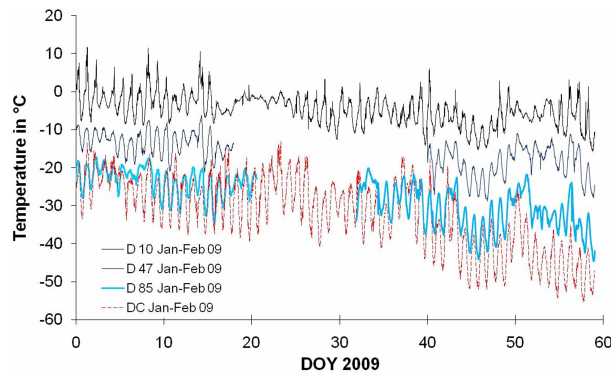
Fig. 12. Time series of temperature along the traverse in January and February 2009. DOY=Day Of Year. Data from AWSs.